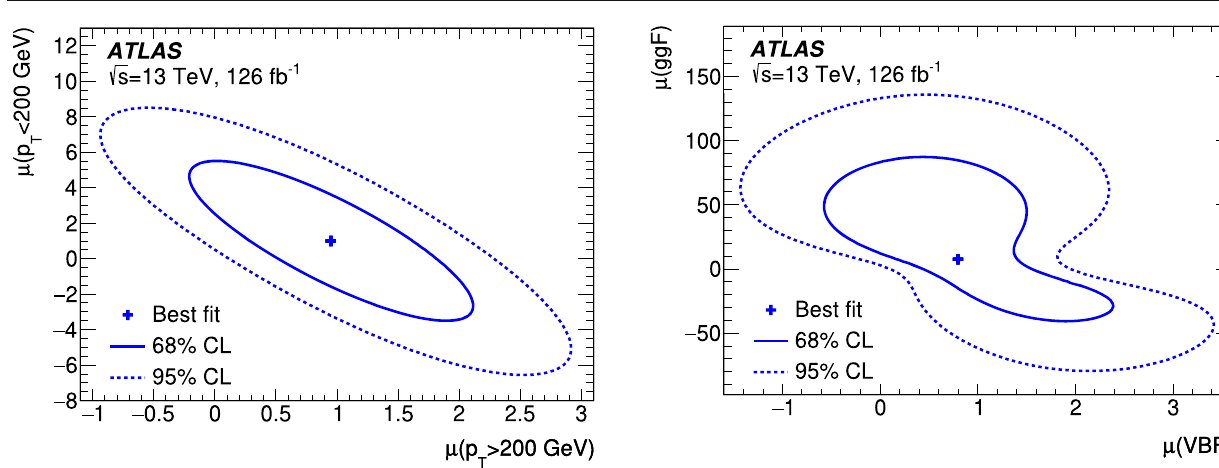
Fig. 7 Likelihood scan as a function of the signal strength for Higgs boson production with true boson p T > 200GeV versus the signal strength for Higgs boson production with true boson p T < 200GeV. Shown is the best-fit value (blue plus sign), and the 68% (solid blue) and 95% (dashed blue) confidence level (CL) contours